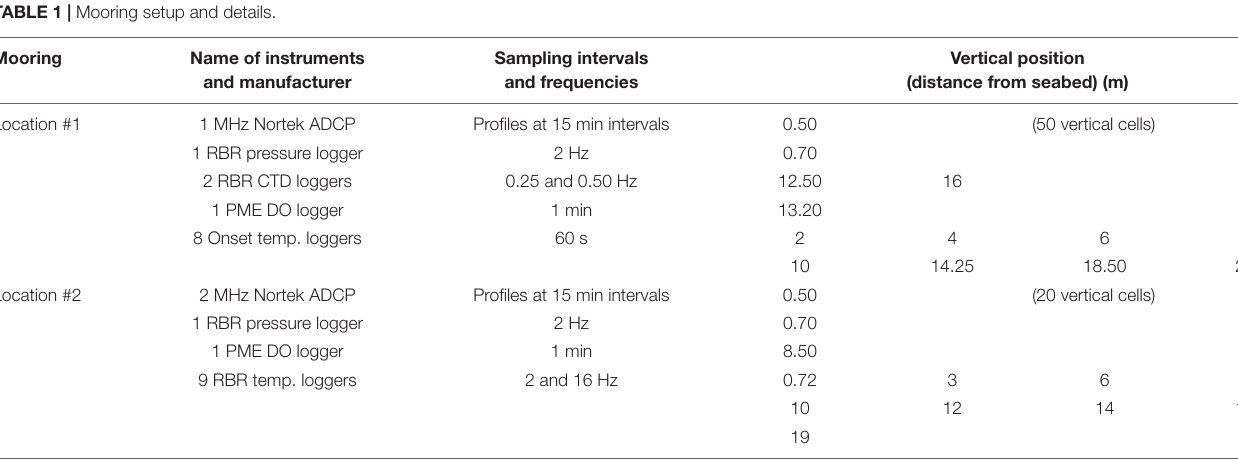
TABLE 1 | Mooring setup and details. Sampling intervals Vertical position and manufacturer (distance from seabed)